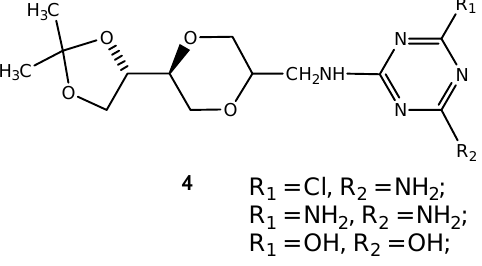
Figure 5. Structure of triazine homo- N -nucleoside